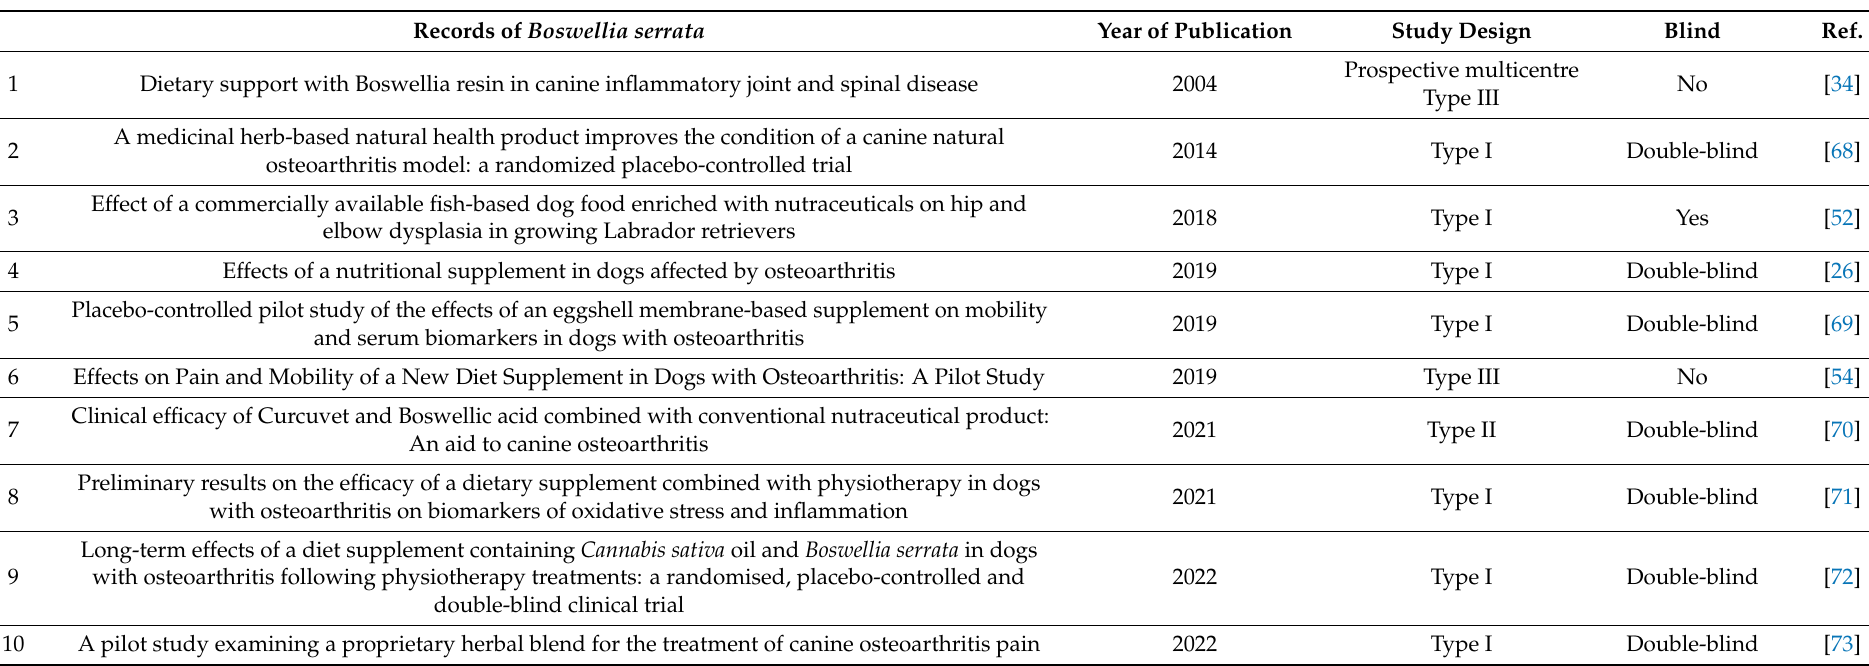
Table 3. Records included in the review based on the search performed regarding Boswellia serrata for managing clinical signs of osteoarthritis and joint support in dogs.